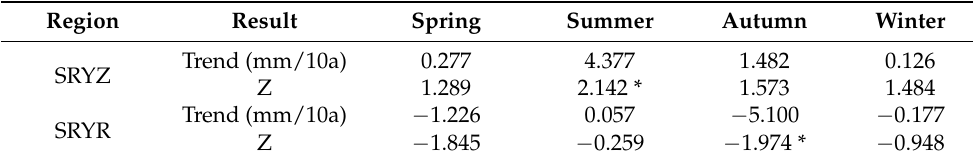
Table 1. The MK test results of annual and seasonal runoff series in the SRYZ and SRYR.